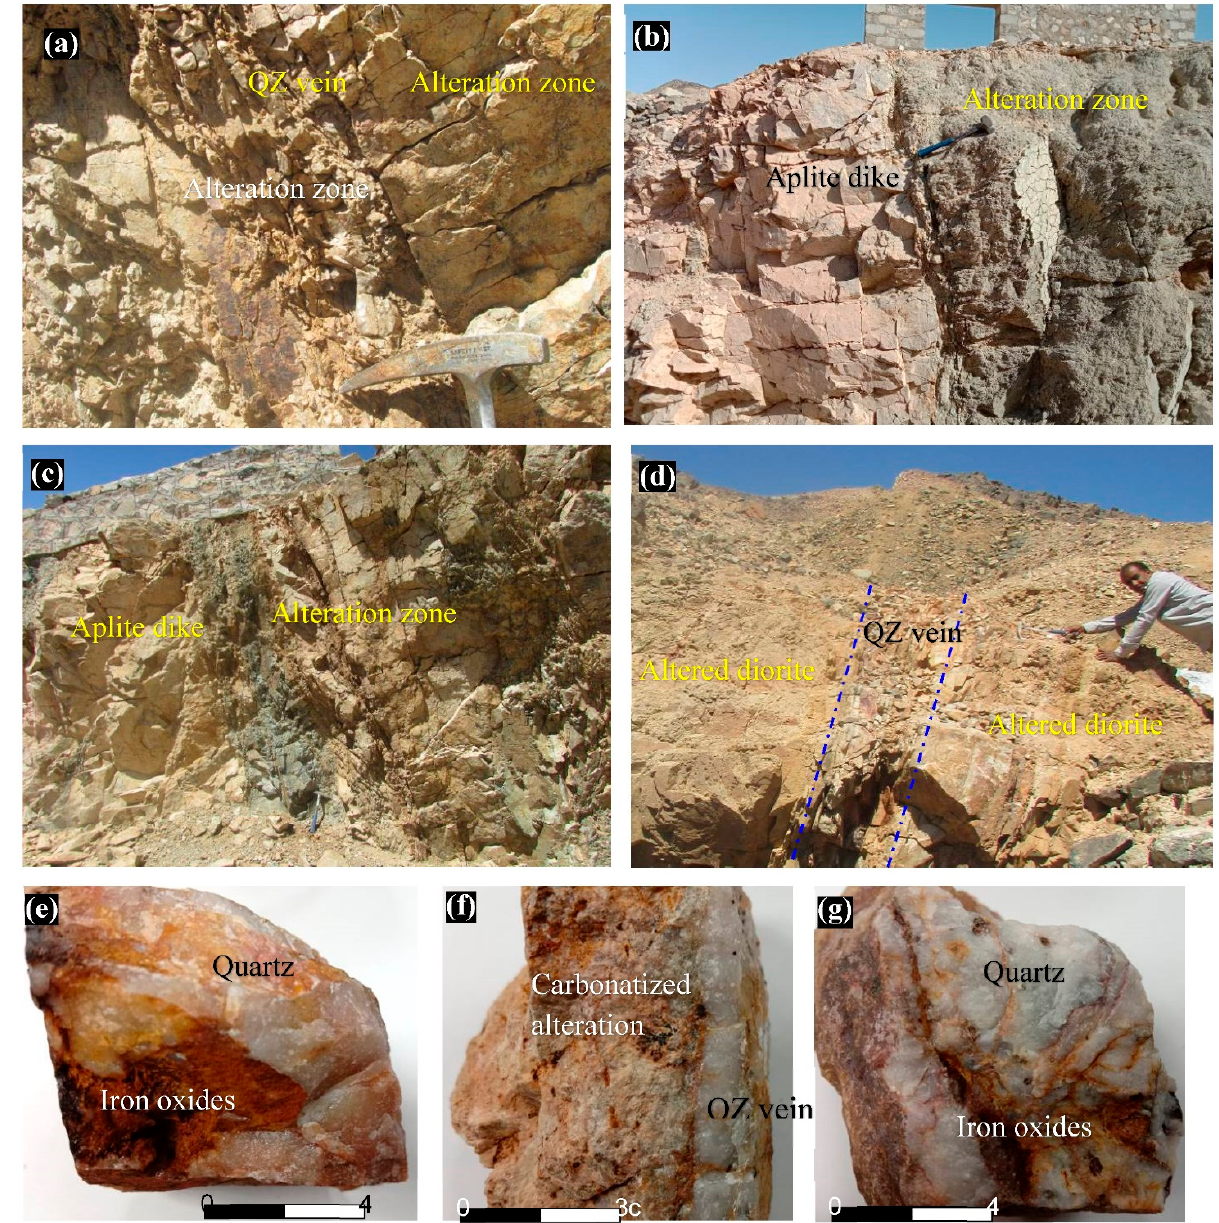
Figure 10. Field photographs: ( a ) quartz vein in argillic-silica alteration zone, photo looking NW, dipping ~60 E; ( b ) aplite and altered diorites, photo looking ~N-S; ( c ) aplite and alteration zone, photo looking ~NW; ( d ) quartz vein surrounded by altered rocks; ( e ) quartz with vugs filled by iron-oxides; ( f ) quartz vein surrounded by iron-oxides and carbonates along wall; Mn displays in dendritic shape; ( g ) massive quartz with reddish veins and vugs.